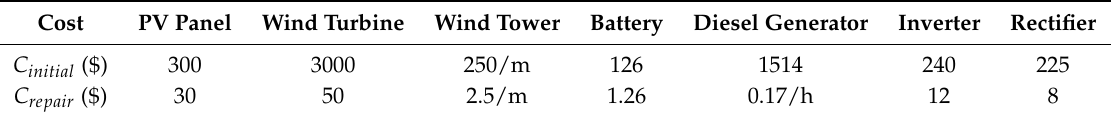
Table 1. The initial cost (per unit) and the annual repair expenses of the system components in HRES.